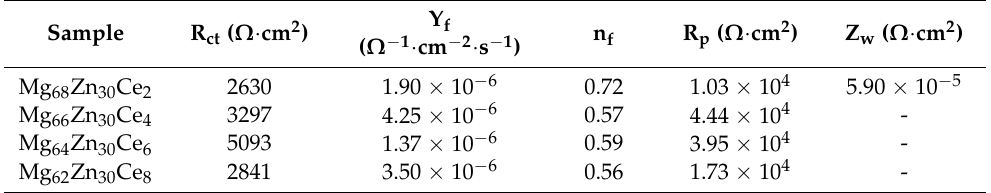
Table 2. The first part fitting results for each component in the equivalent circuit diagram.